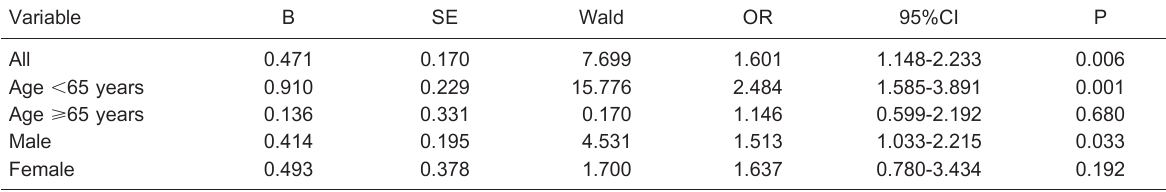
Table 3. Association between the IL-18 promoter -607C/A (rs1946518) polymorphism and ischemic stroke